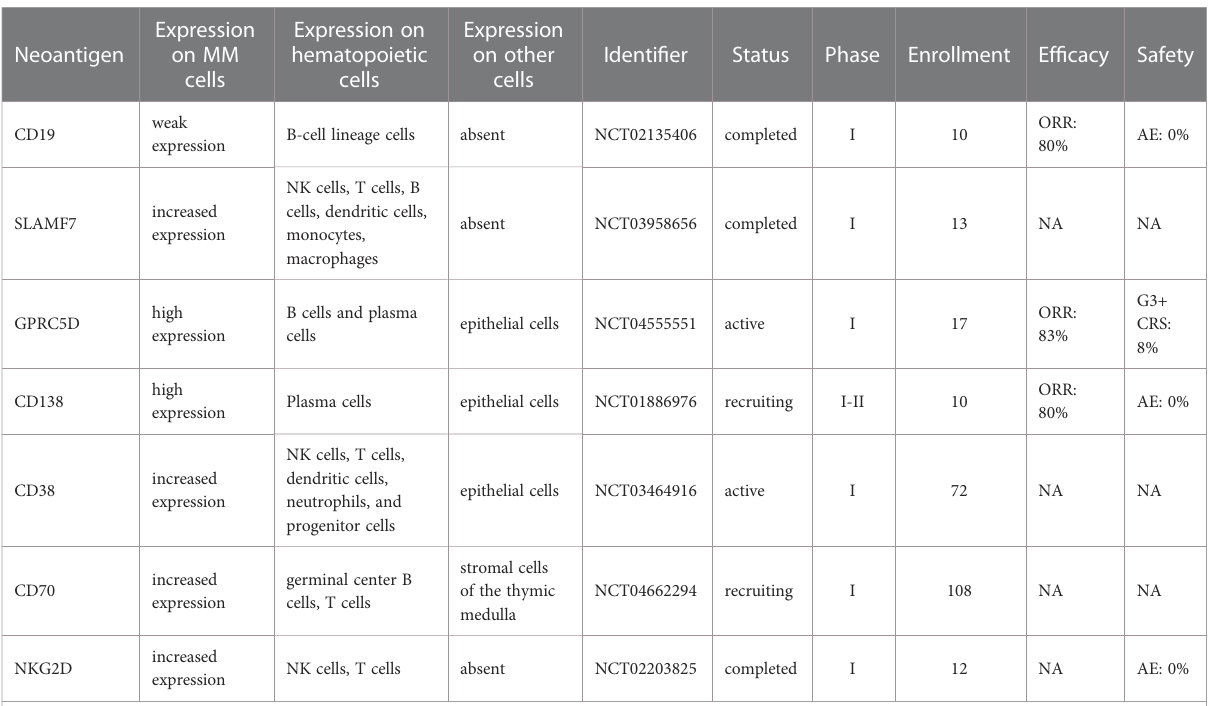
TABLE 2 Selected non-BCMA-targeted CAR-T clinical trials for